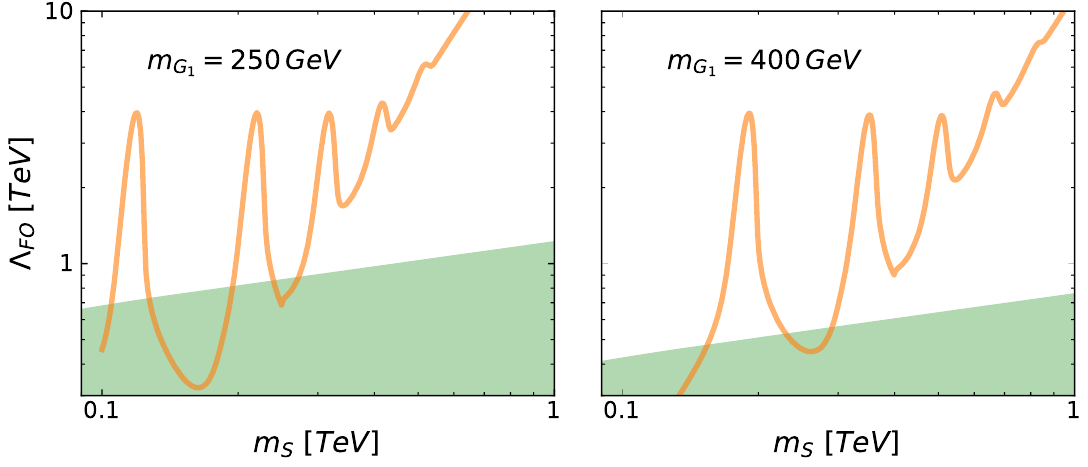
Figure 9 . The DD bounds in the ( m shaded area. Also shown is the dependence of (cid:3) FO on the scalar DM mass m S for (cid:12)xed m G (cid:3) FO the value of (cid:3) for which the freeze-out thermally-averaged cross-section h (cid:27) FO v i is achieved for the chosen values of m S and m G